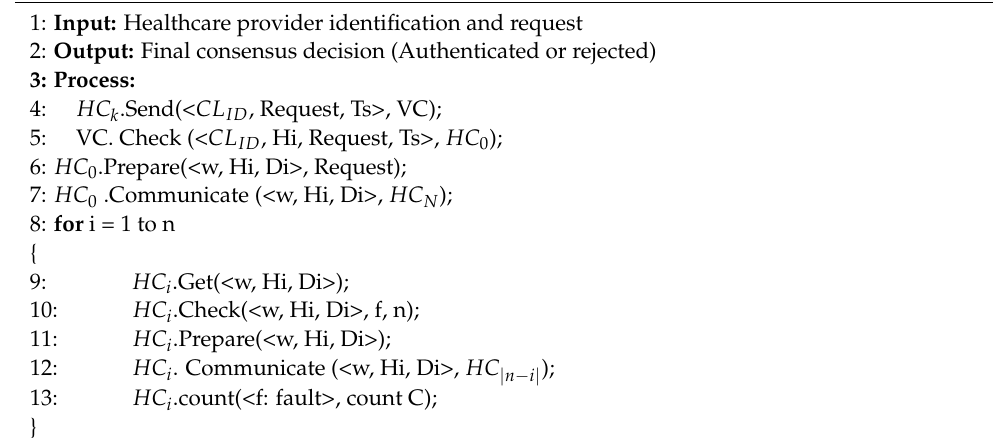
Algorithm 1. Cluster pre-selection (message